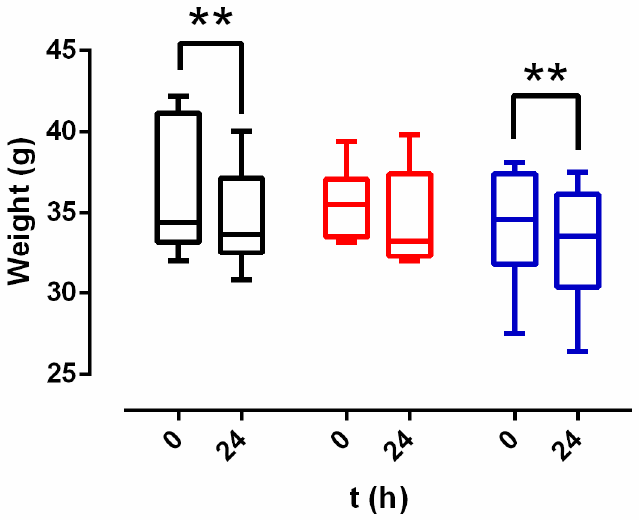
Figure 9. Weight results of each experimental group: positive control (black), sanguiin H-6 (red), and lambertianin C (blue). **: p- value < 0.01 for paired Wilcoxon test.